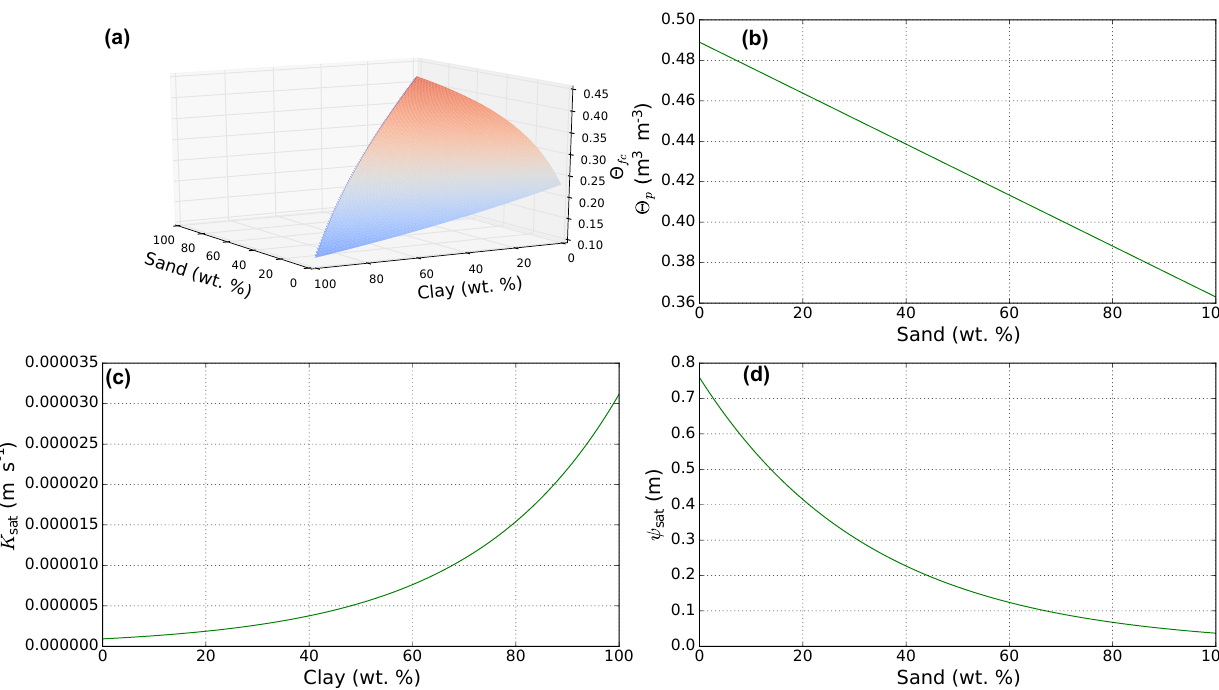
Figure A12. Relationships between soil texture and field capacity ( θ fc ; a ), pore volume ( θ p ; b ), saturated hydraulic conductivity ( K sat ; c ), and soil moisture suction at saturation ( (cid:57) sat ; d ) following Cosby et al. (1984) as implemented in Verseghy